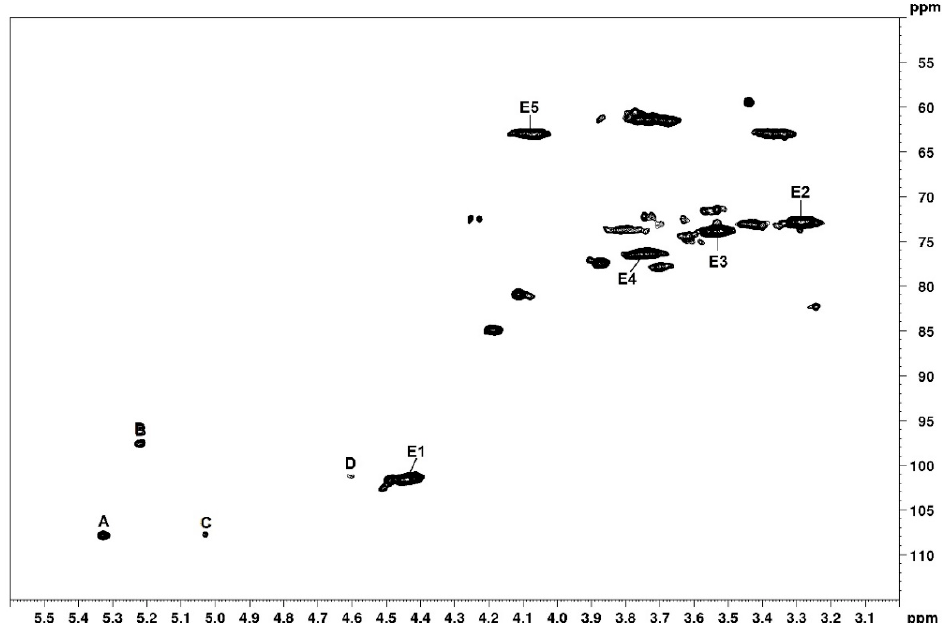
Figure 1. HSQC spectra of xylan from corn cob.